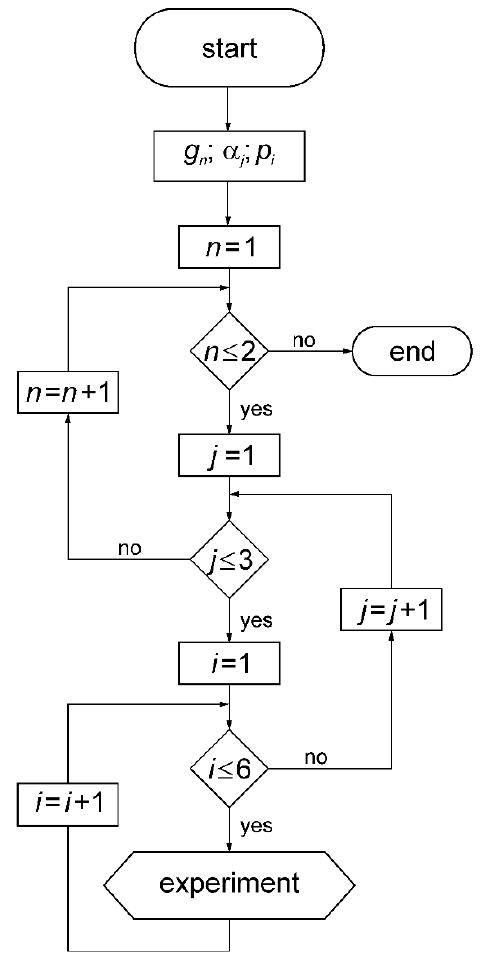
Figure 9. The algorithm used for measurements of the transverse rye and oat seed sowing evenness: n, j, i —consecutive numbers (values) of variable parameters ( g, α , p).